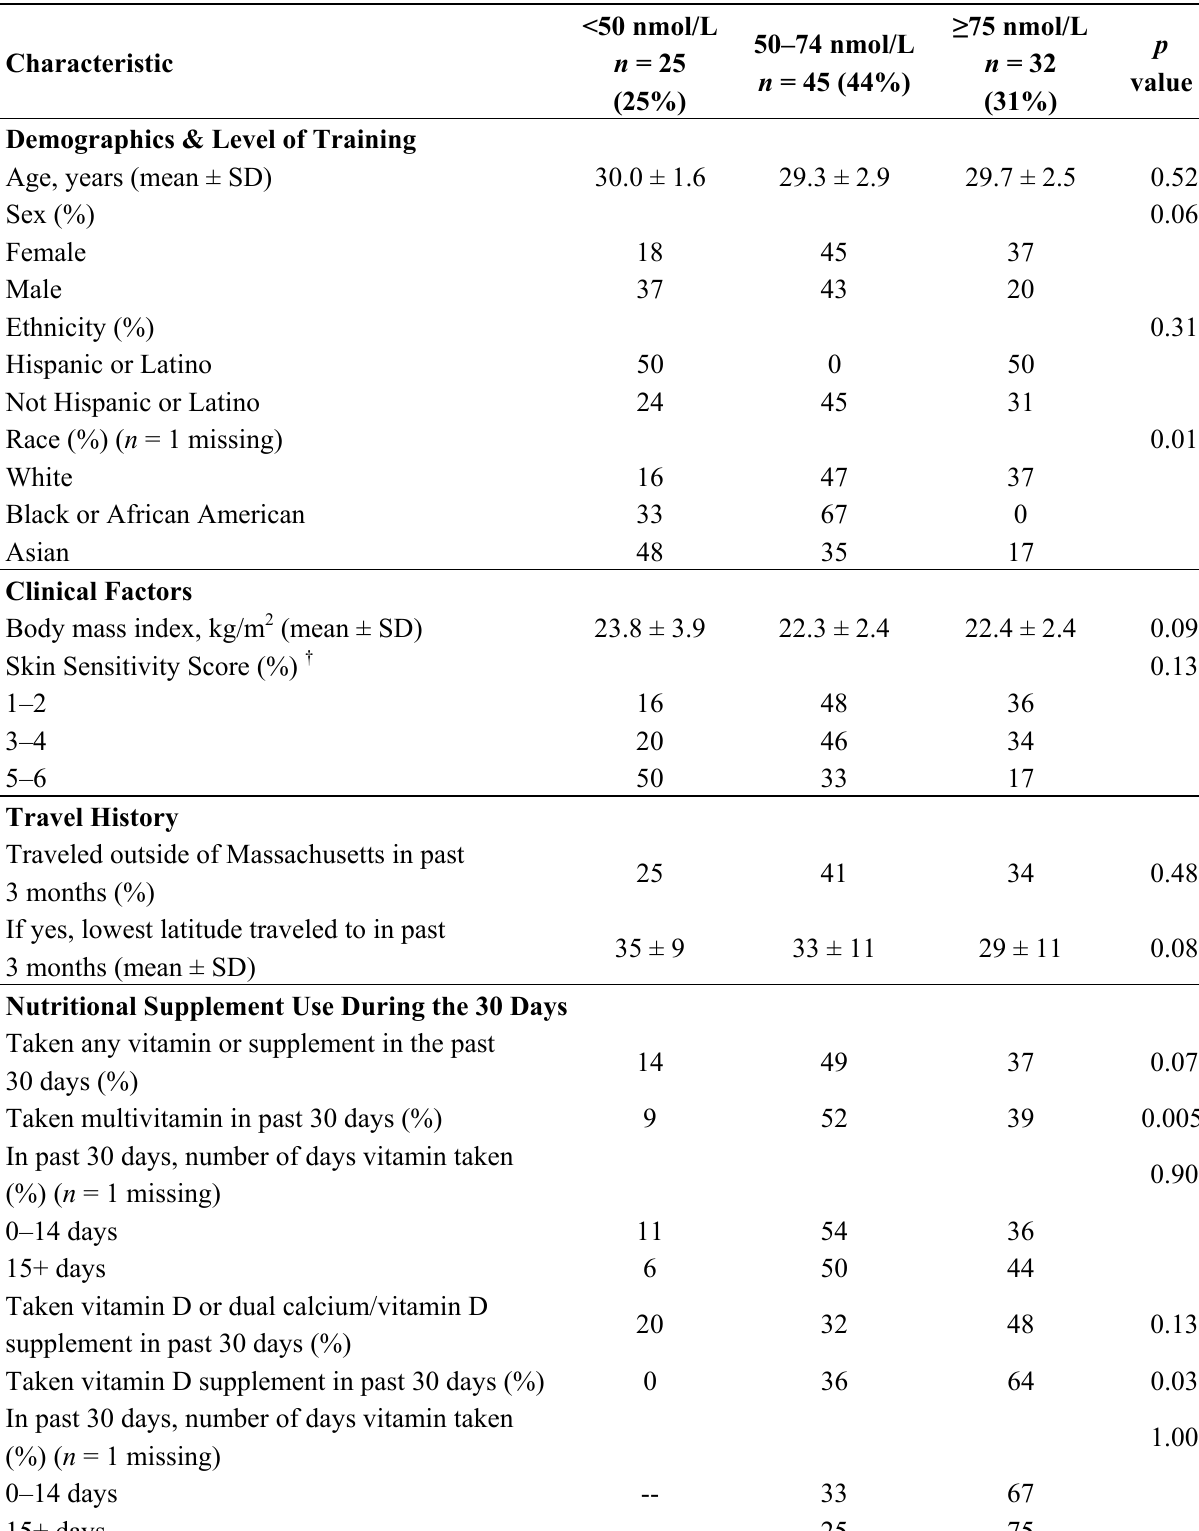
Table 2. Resident Characteristics and Dietary Patterns According to Serum 25(OH)D Level *.